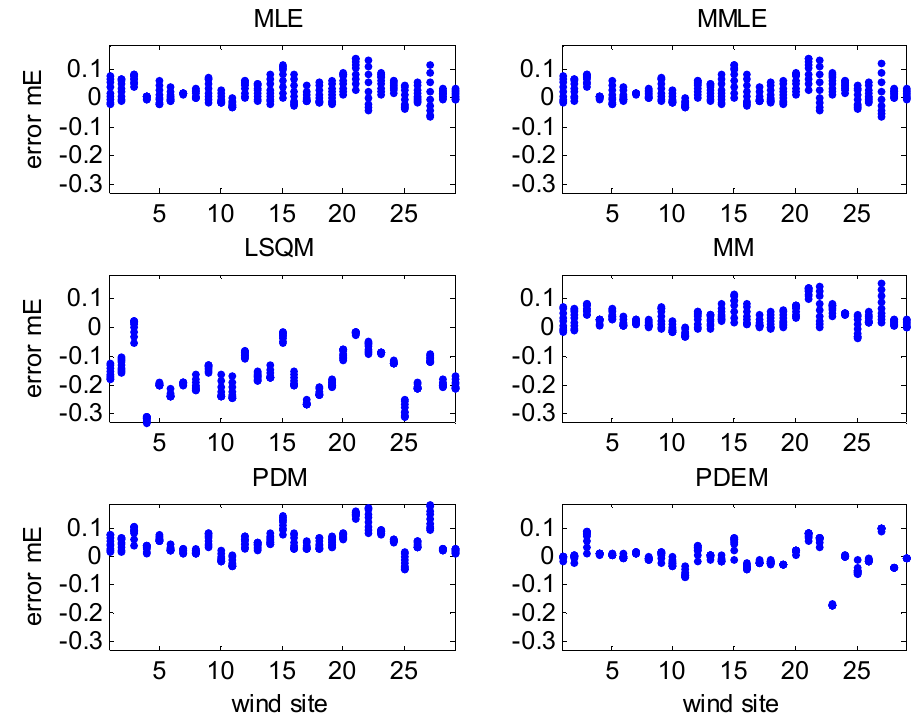
Figure 15. Representation of each component of error the different wind sites. For each wind site, the final value of error all the components.